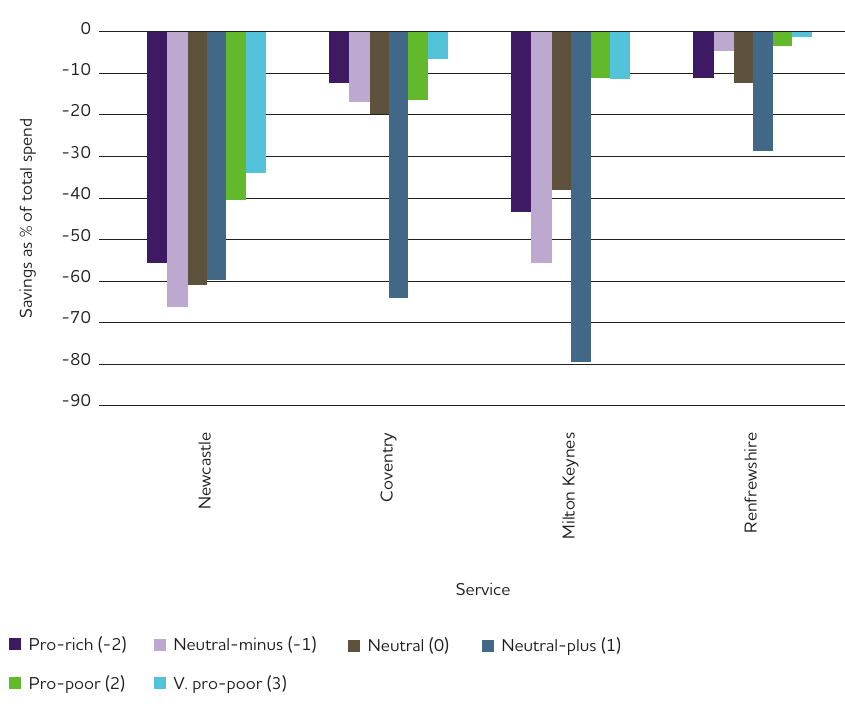
Figure 20: Relative savings by distributional character of